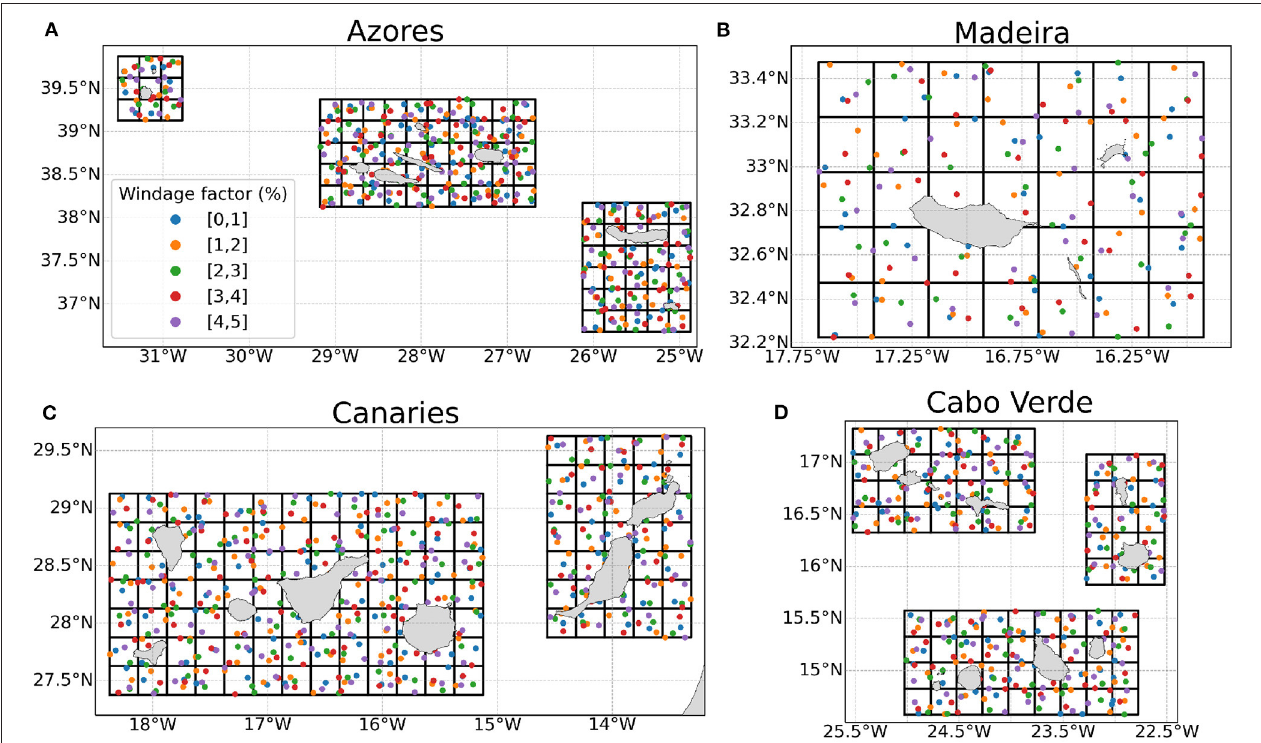
FIGURE 2 | Example of the release location of particles in the (A) Azores, (B) Madeira, (C) Canaries, and (D) Cabo Verde archipelagos. Black grids around the islands represent the boundaries in which particles are randomly released. Colors represent the particle windage groups.